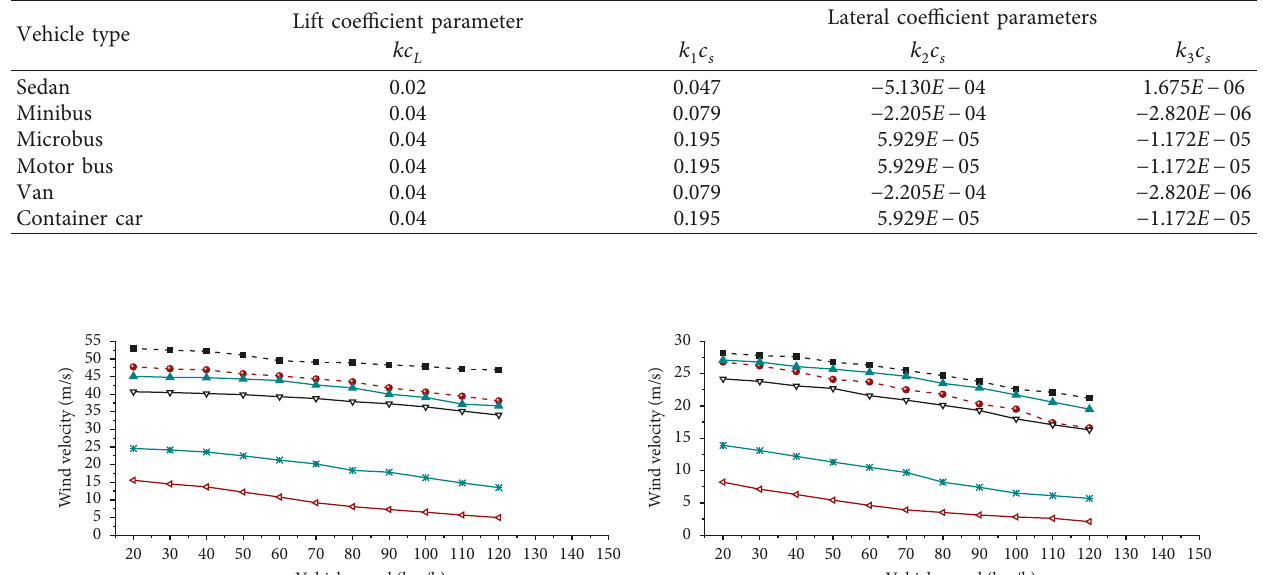
Table 3: Aerodynamic coefficient parameters.